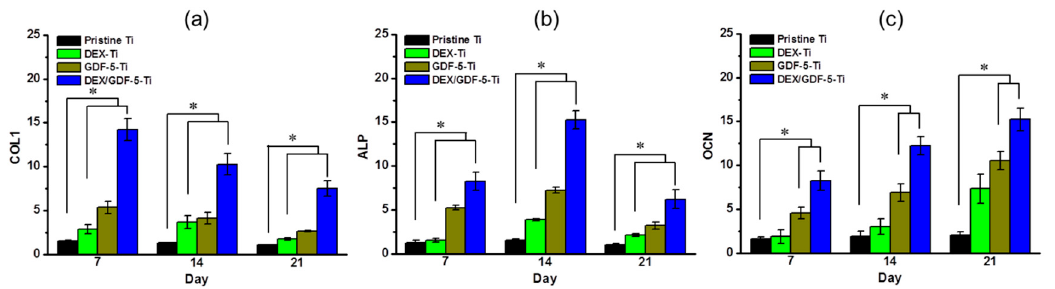
Figure 7. Level of ( a ) type I collagen (COL 1); ( b ) ALP and ( c ) osteocalcin (OCN), mRNA expression for pristine Ti, DEX–Ti, GDF-5–Ti and DEX/GDF-5–Ti disc samples cultured with MC3T3-E1 cells for 7, 14 and 21 days. The error bars represent mean ± SD ( n = 3). These experiments were repeated three times (* p < 0.05).